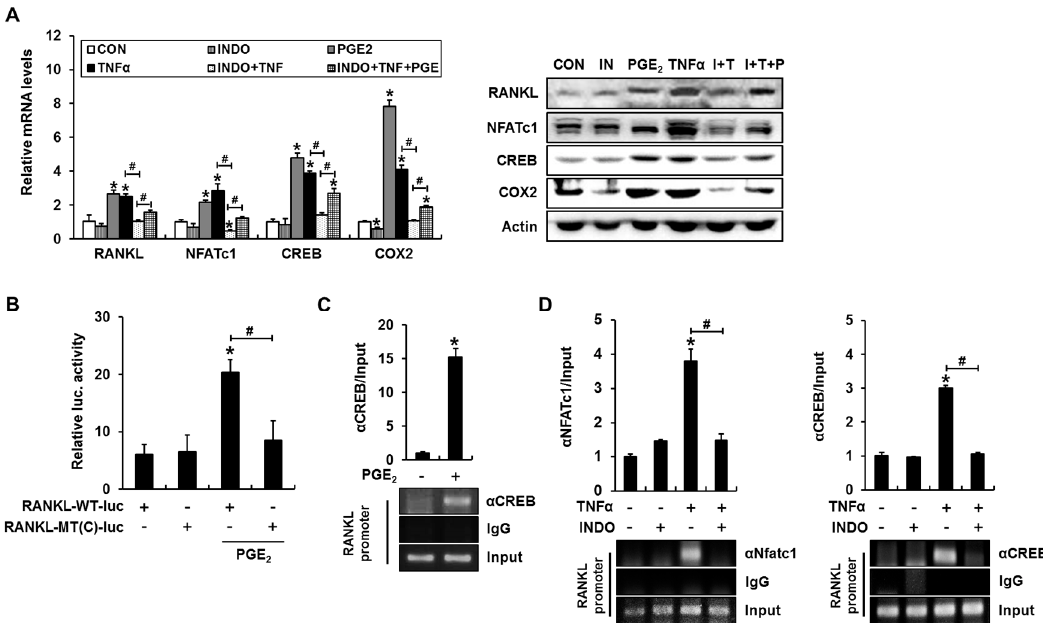
Figure 4. The COX inhibitor indomethacin blocks TNF α -induced binding of NFATc1 and cAMP response element-binding protein (CREB) to the RANKL promoter in C2C12 cells. ( A ) PGE 2 increased the expression of RANKL , NFATc1, CREB, and COX2, whereas indomethacin suppressed TNF α -mediated RANKL , NFATc1, CREB, and COX2 expression. Treatment with PGE 2 in the presence of indomethacin and TNF α partially rescued the expression of RANKL , NFATc1, CREB, and COX2. C2C12 cells were incubated with the indicated reagents for 24 h and subjected to RT-PCR and western blot analyses; ( B ) PGE 2 increased RANKL promoter–reporter activity in a CREB binding element-dependent manner. C2C12 cells were transfected with RANKL -WT-luc or a CREB-binding site mutant ( RANKL -MT(C)-luc) RANKL promoter, incubated for 24 h in the presence of PGE 2 , and subjected to a luciferase assay; ( C ) PGE 2 induced CREB binding to the mouse RANKL promoter. C2C12 cells were incubated for 24 h with PGE 2 and subjected to a ChIP assay with CREB and control IgG antibodies. The RANKL promoter region containing the CREB-binding element was then amplified; ( D ) Indomethacin prevented TNF α -induced NFAT and CREB binding to the mouse RANKL promoter. C2C12 cells were incubated for 24 h with the indicated reagents and subjected to a ChIP assay (* p < 0.05, compared to control; # p < 0.05).